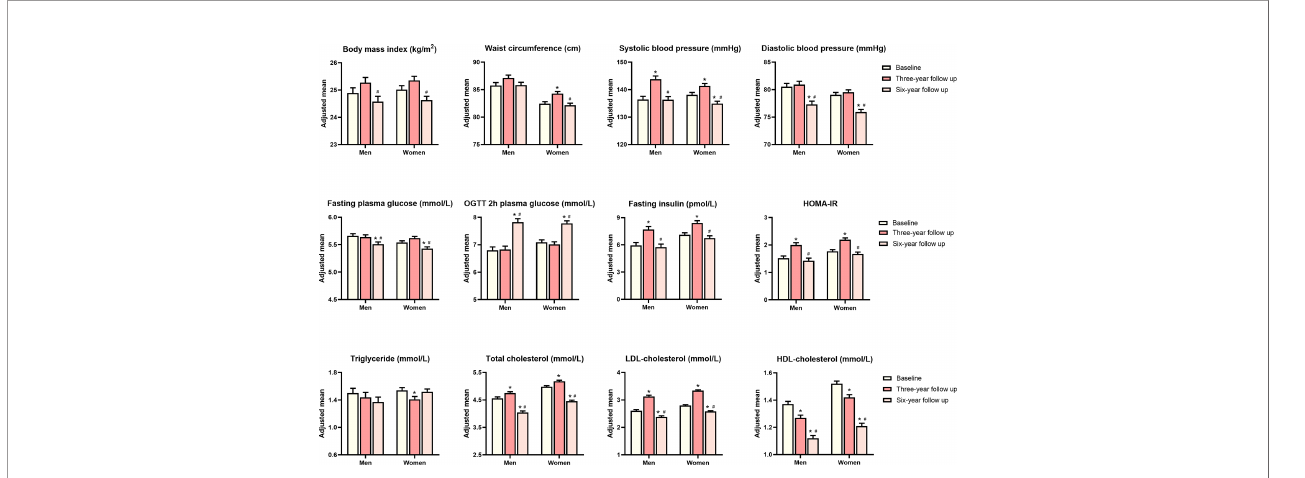
FIGURE 2 | Age adjusted means of metabolic traits at baseline, 3-year follow-up and 6-year follow-up. P values were calculated from analysis of covariance. *P value signi fi cant compared with baseline, # P value signi fi cant compared with 3-year